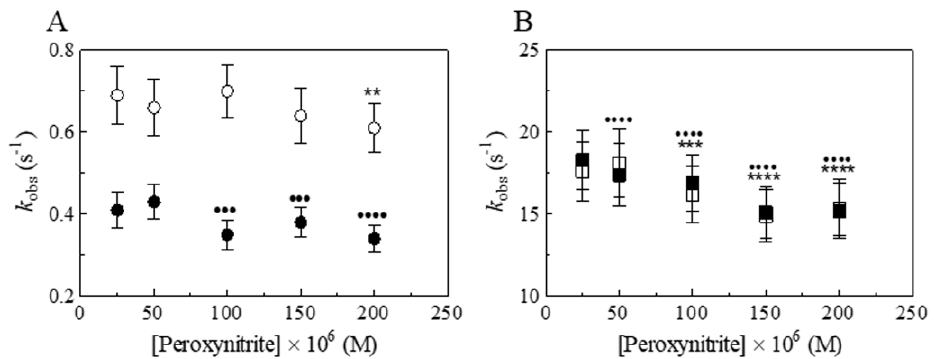
Figure 4. Effect of peroxynitrite concentration on the values of k obs for the isomerization of peroxynitrite by Dr -Nb(III) and apo- Dr -Nb in the absence and presence of CO 2 , at pH 7.0 and 22.0 ◦ C. ( A ) Dependence of k obs on the peroxynitrite concentration in the presence of Dr -Nb(III) (open circles) and apo- Dr -Nb (filled circles), in the absence of CO 2 (One-way ANOVA: open circles, ** p < 0.01, 25 × 10 − 6 M versus 200 × 10 − 6 M; filled circles, ••• p < 0.001, 25 × 10 − 6 M versus 100 × 10 − 6 M and versus 150 × 10 − 6 M, •••• p < 0.0001, 25 × 10 − 6 M versus 200 × 10 − 6 M). ( B ) Dependence of k obs on the peroxynitrite concentration in the presence of Dr -Nb(III) (open squares) and apo- Dr -Nb (filled squares), in the presence of CO 2 (One-way ANOVA: open squares, *** p < 0.001, 25 × 10 − 6 M versus 100 × 10 − 6 M, **** p < 0.0001, 25 × 10 − 6 M versus 150 × 10 − 6 M and versus 200 × 10 − 6 M; filled squares, •••• p < 0.0001, 25 × 10 − 6 M versus 50 × 10 − 6 M, 100 × 10 − 6 M, 150 × 10 − 6 M, and 200 × 10 − 6 M). The Dr -Nb(III) and apo- Dr -Nb(III) concentration was 5.0 × 10 − 6 M. The HCO 3 − concentration was 5.0 × 10 − 1